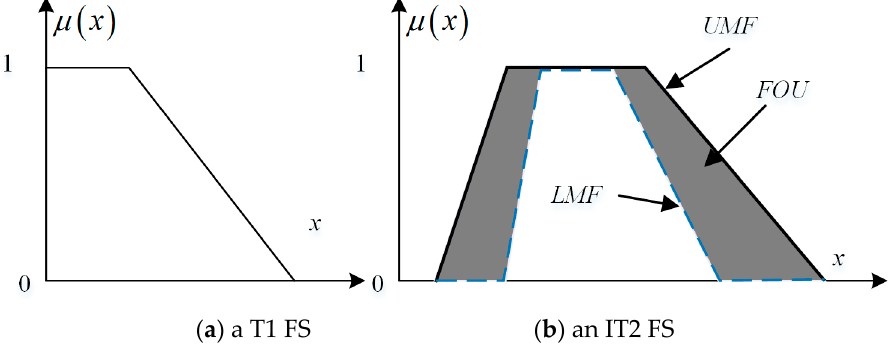
Figure 2. Type-1 fuzzy set and interval type-2 fuzzy set.